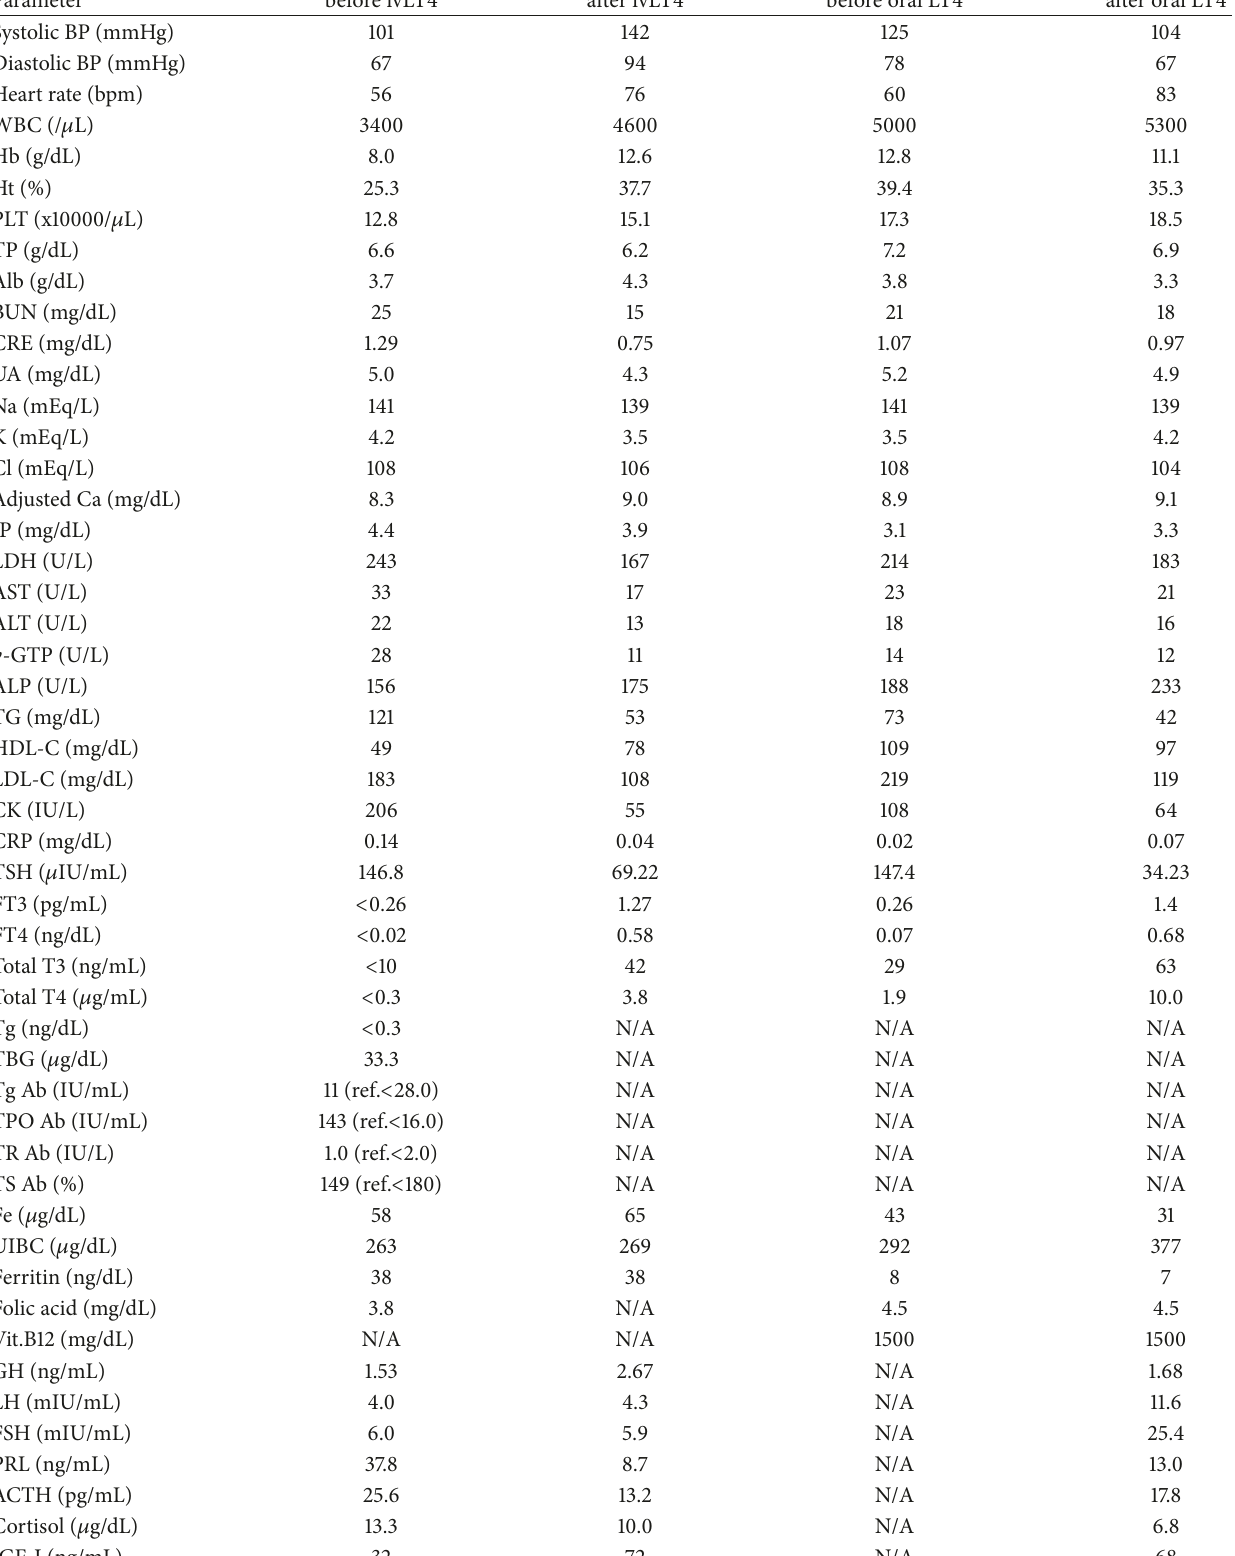
Table 1: Changes in parameters following the intravenous (ivLT4) or oral administration of